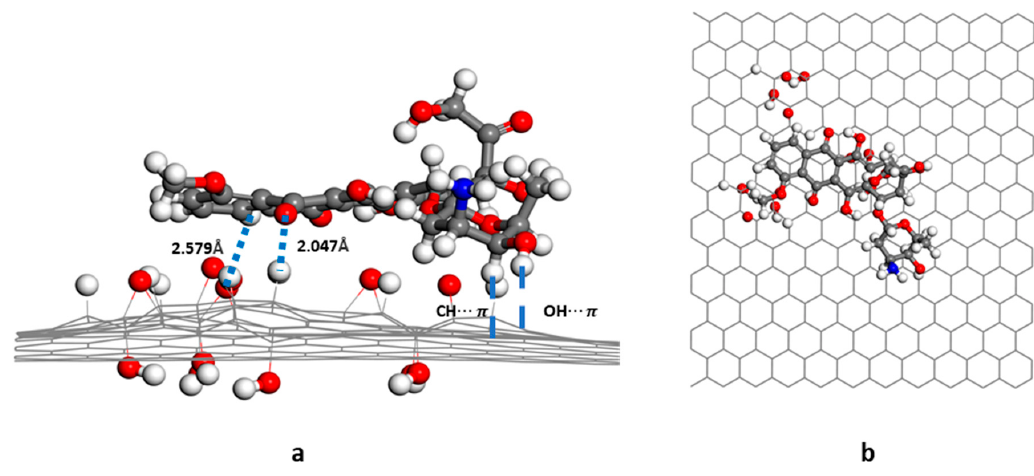
Figure 6. Energy-minimized structure of GO-O-DOX; ( a ) side view; ( b ) top view. The interactions between DOX and the graphene system can have a significant effect on the hydrogen bonds within the DOX molecules. Table 2 shows the lengths of the hydrogen bonds within the DOX and graphene system molecules. The hydrogen bonds within the DOX molecules were slightly shortened, and when DOX was adsorbed onto the GO-OH-O- surface, the O4-H bond broke, and an N-H bond was formed.